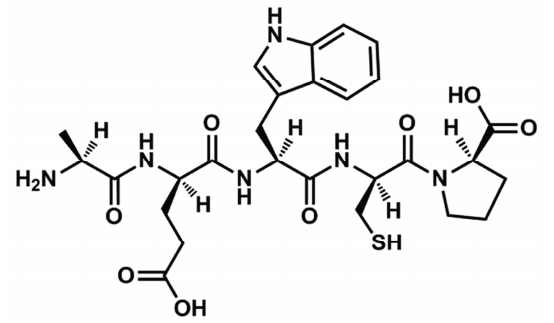
Figure 1. Chemical structure of TIPP.